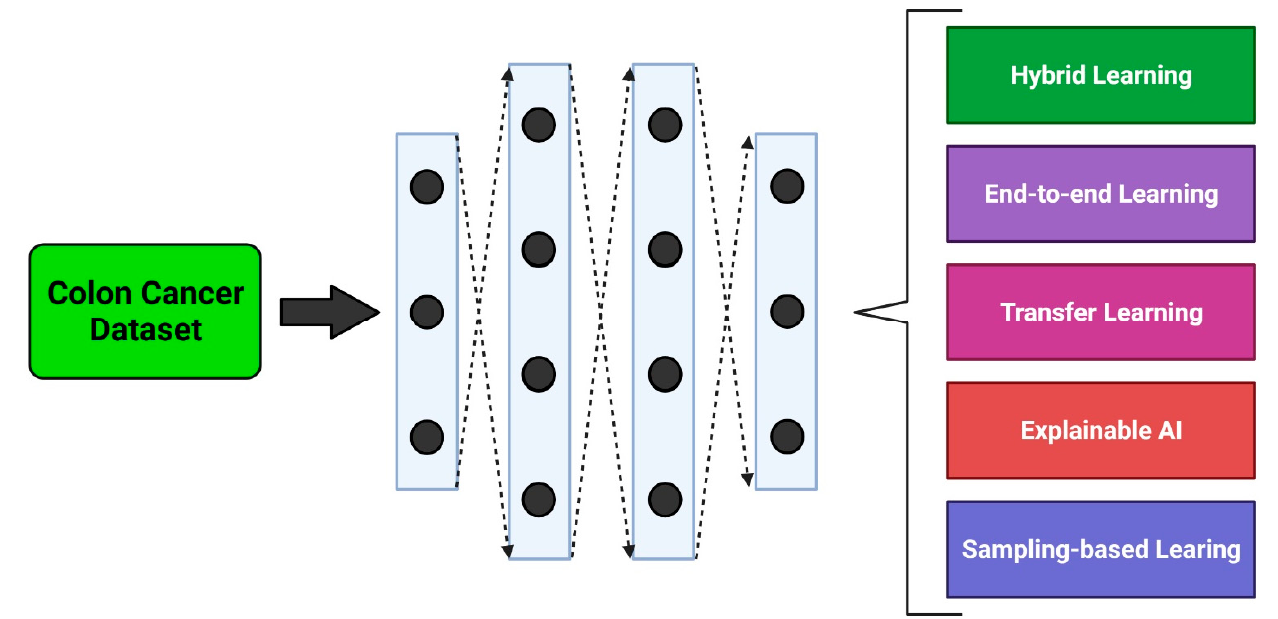
Figure 1. An overview of deep learning models in colon cancer detection and diagnosis. Created with BioRender.com (accessed on 1 July 2022).